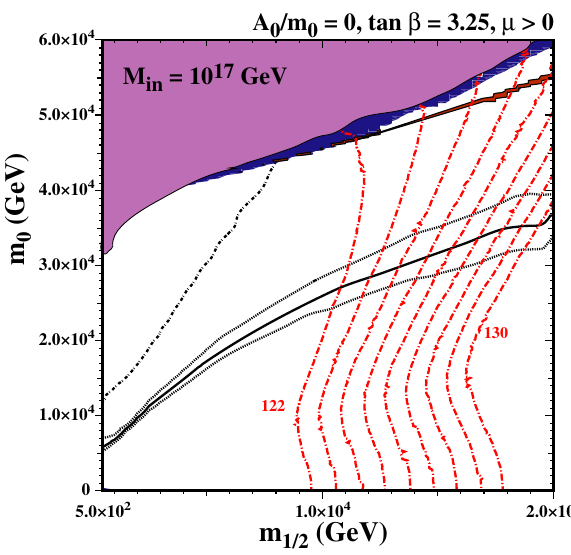
Fig. 14 The ( m 1 / 2 , m 0 ) plane in the super-GUT model with M in = 10 17 GeV for tan β = 3 . 25, A 0 / m 0 = 0 and μ > 0, which exhibits a focus-point strip at large m 0